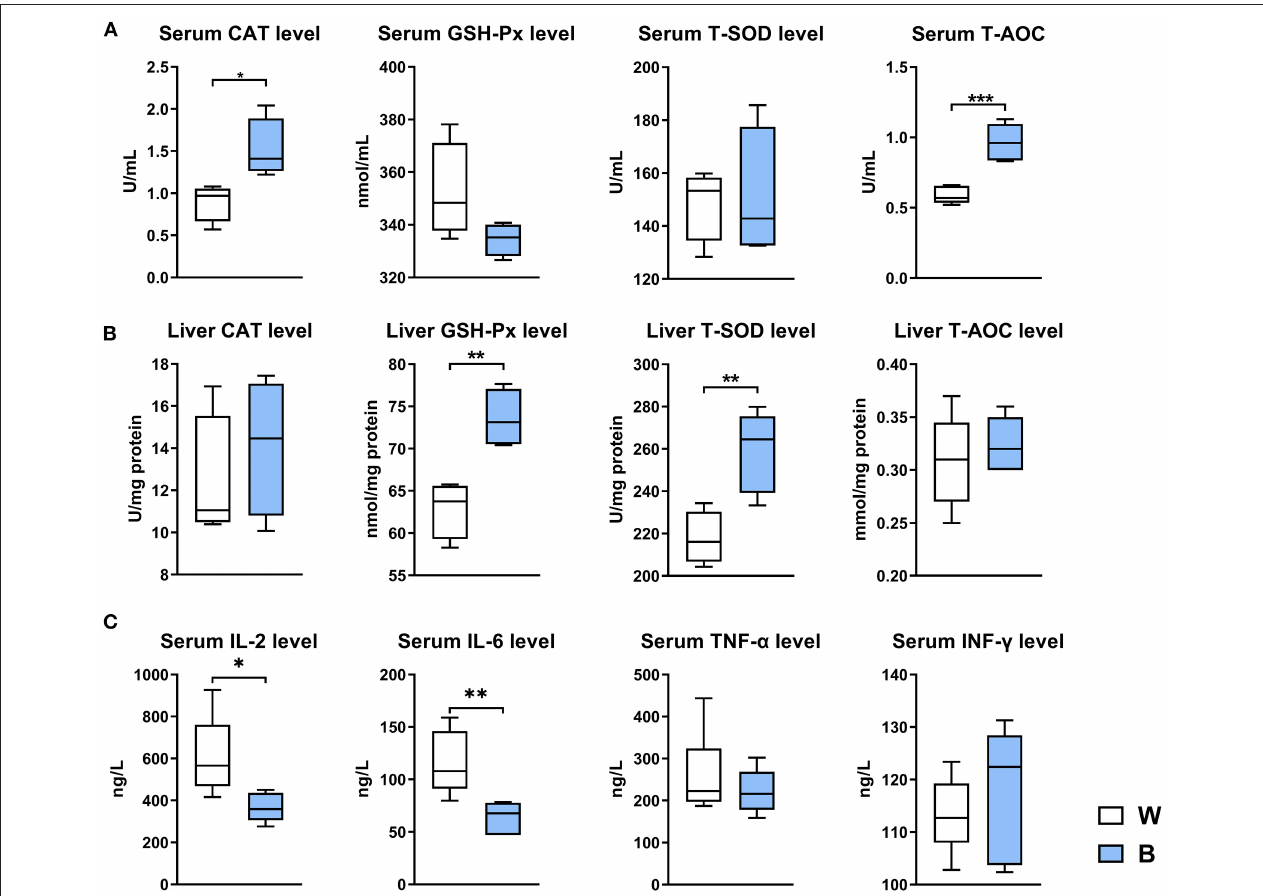
FIGURE 2 | Exposure to blue light improves the antioxidant and anti-inflammatory capacities in ducks. (A) Effect of exposure to 460nm LED blue light on the serum antioxidant indicators CAT, GSH-Px, T-SOD, and T-AOC in ducks ( n = 6, mean with SEM). (B) Effect of exposure to blue light on the liver antioxidant indicators CAT, GSH-Px, T-SOD, and T-AOC in ducks ( n = 6, mean with SEM). (C) Effect of exposure to blue light on serum cytokine levels in ducks, including IL-2 IL-6, TNF- α , and IFN- γ ( n = 6, mean with SEM). Data in (A–C) were analyzed using the unpaired t -test, * P < 0.05, ** P < 0.01, *** P <